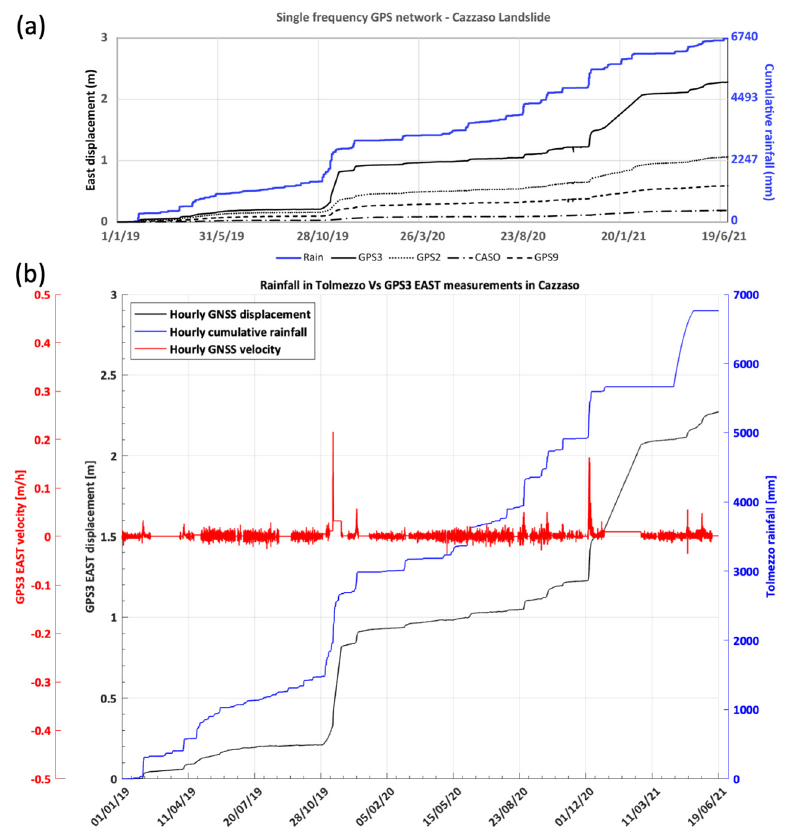
Figure 4. ( a ) Displacement toward the East recorded by the cost-effective, single-frequency GNSS network on the Cazzaso landslide between 1 January 2019 and30 June 2021. The black lines with different patterns indicate the different GPS stations. The blue line indicates the cumulative meas- urement of rainfall recorded by the Tolmezzo rainfall gauge (near TOLS station); ( b ) Detailed plot of the GPS3 eastern displacement compared with the rainfall gauge values in Tolmezzo; the GPS3 hourly velocity (East component) is also included to highlight the fastest rain phenomena that had the greatest impact on GPS3’s movements.